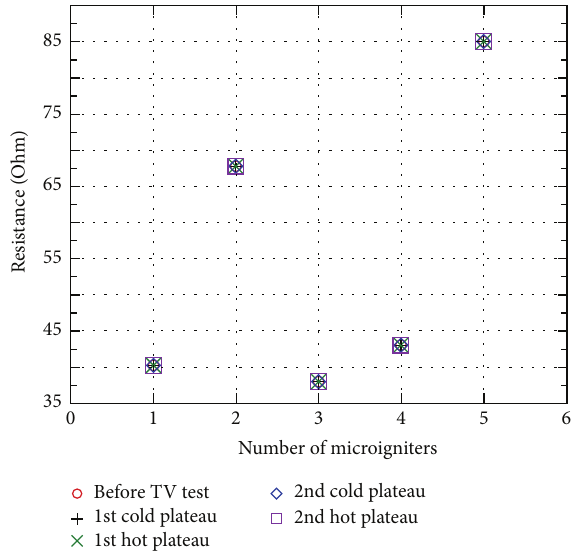
Figure 19: Resistance values for microigniters of MEMS thruster measured during each test phase.